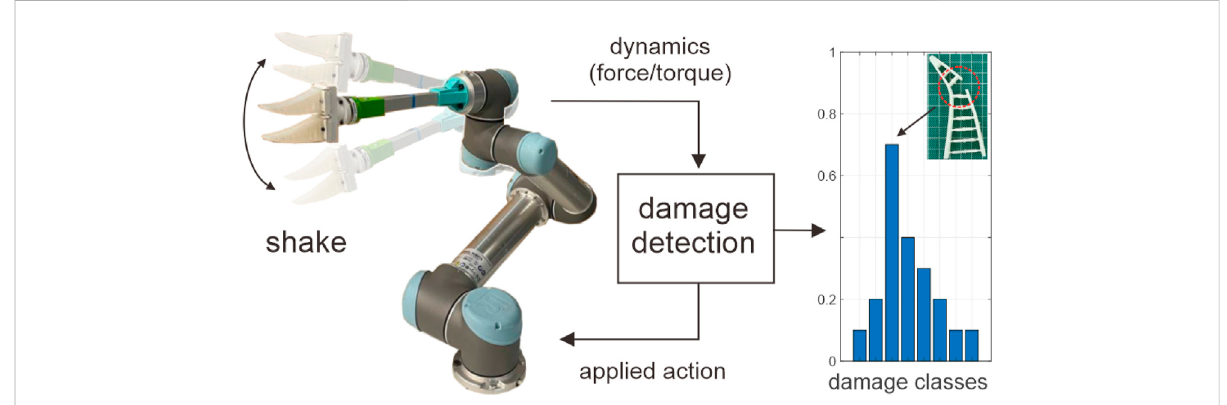
FIGURE 1 Overviewoftheproposeddamagedetectionandlocalizationconcept.Thealgorithmappliesvariousactionconditionsandtracksthechangein dynamics(force/torquefeedback)intime.Resultantfeedbackisthenusedtoclassifythedamageintooneofthepre-traineddamagecon fi